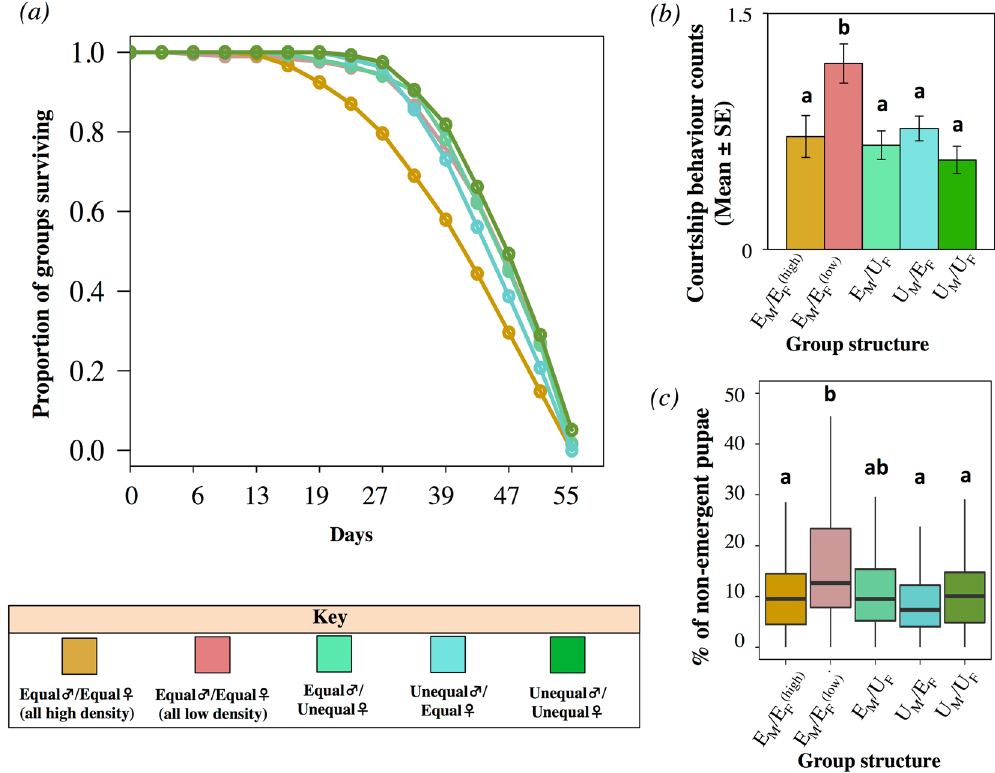
Figure 2. Survival, courtship levels, and pupae eclosion. ( a ) Proportion of groups surviving throughout the experiment. Likelihood ratio test = 20.74, df = 5, p < 0.001. ( b ) Courtship levels in the treatments. ( c ) Pupae eclosion success (in %) measured as the number of non-emergent pupae. Post-hoc SNK test ( α =